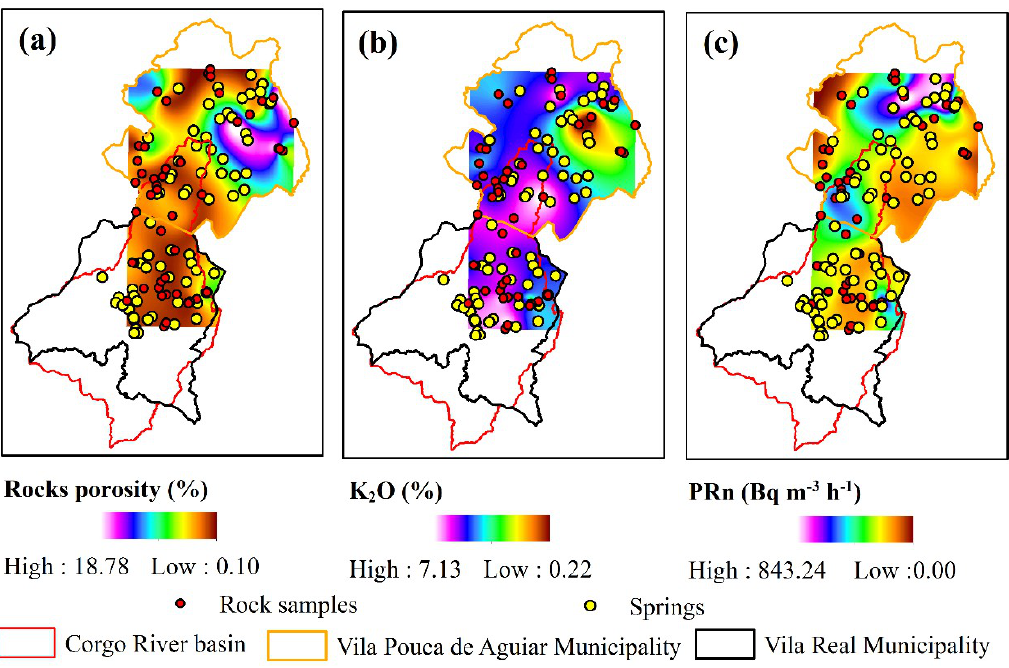
Figure 3. The geogenic interpolated maps from rocks: ( a ) Rocks porosity, ( b ) K 2 O contents, and ( c ) radon production potential [36]. These maps were digitally sampled in ArcMap [45] using the Topo to Raster tool and the Extract Multi Values to Points tool, as to obtain the values of all features for each water collection point.